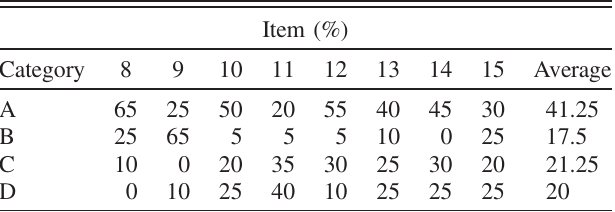
TABLE IV. Percentage of textbooks in each